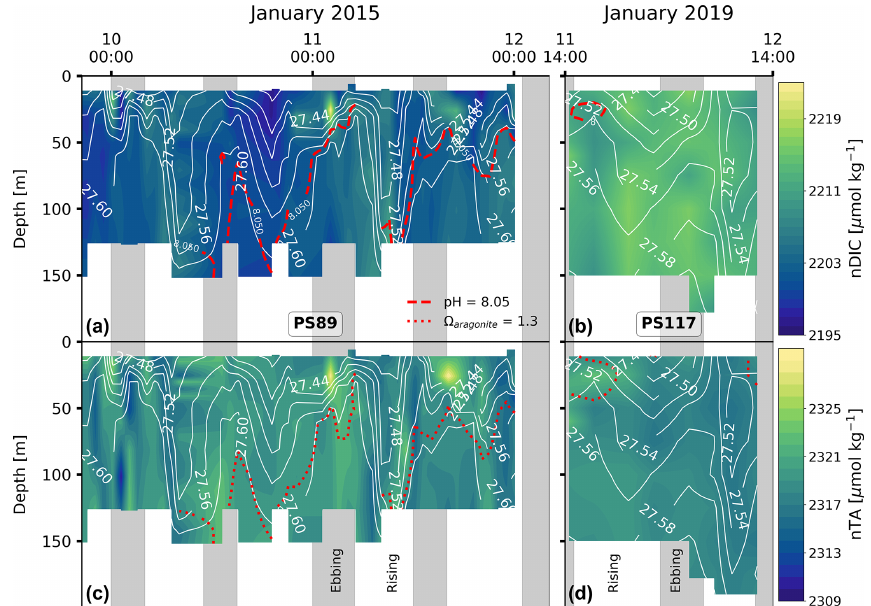
Figure G1. Salinity-normalised DIC content at the sampling site during the PS89 (a) and PS117 (b) tidal observations, as well as salinity- normalised TA content for the PS89 (c) and PS117 (d) observations. White contour lines indicate sigma- t (in kgm − 3 ). Vertical grey-shaded areas indicate periods of ebbing tide, as defined in the text. Dashed red lines in (a) and (b) indicate the depth at which the pH = 8.05. Dotted red lines in (c) and (d) indicate the depth at which the calcite saturation state ( (cid:127) ca ) = 2.05. These are arbitrary values used to illustrate the variability in the water column. The pH ranged between 8.02–8.12 and 8.02–8.06 for PS89 and PS117, respectively. (cid:127) ca ranged between 1.95–2.43 and 1.92–2.13 for PS89 and PS117,